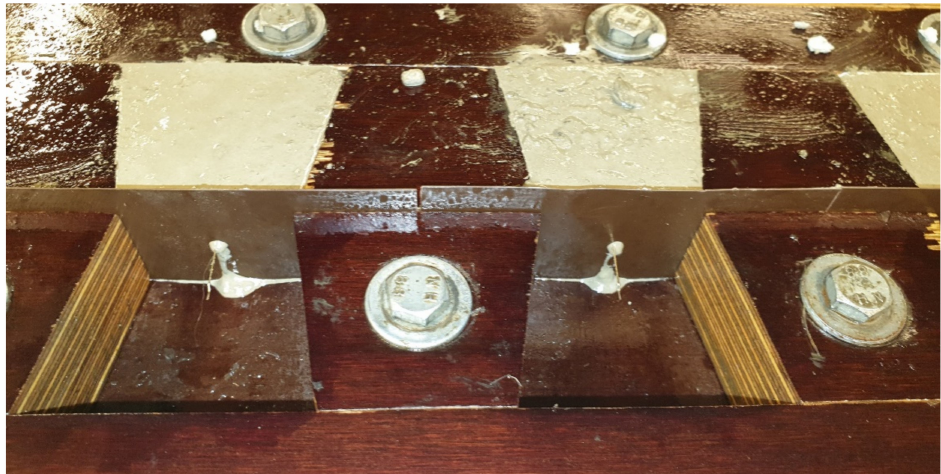
Figure 3. Step 1, preparation of pull-out